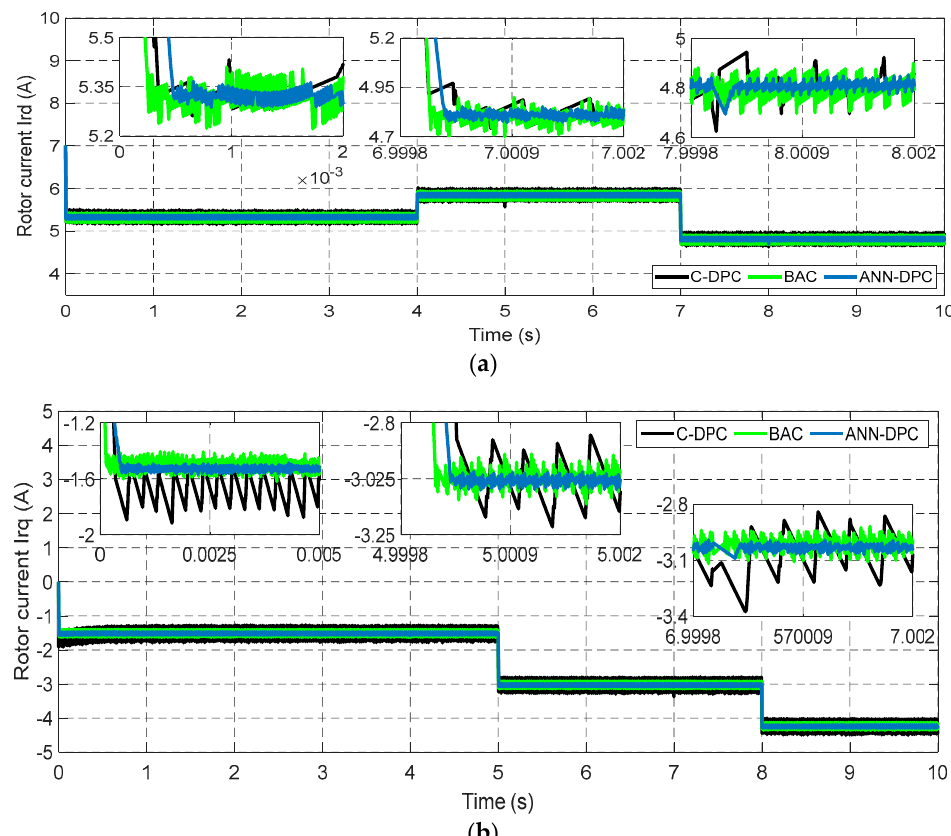
Figure 23. Rotor currents after variation of all parameters of the DFIG with − 50%, ( a ) I rd ,( b ) I rq .